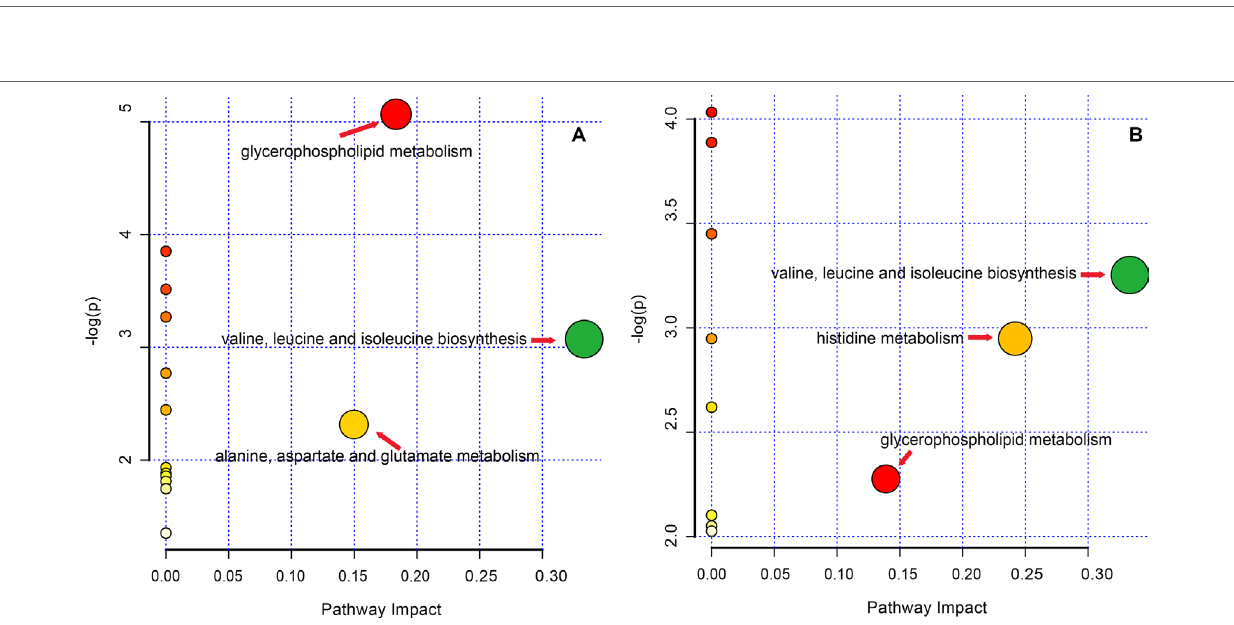
FIGURE 6 | The relative content of common metabolites in the GF, GFC, and NC groups versus the M group. ## P < 0.01, versus the NC group; * P < 0.05, versus the M group; ** p < 0.01, versus the M group. (A) Trans-hexadec-2-enoyl carnitine; (B) 2-hydrohexadecanoylcarnitine; (C) 3-hexenoic acid; (D) lioelaidyl carnitine; (E) L-palmitoylcarnitine; (F) methyl nicotinate; (G) tetradecanoylcarnitine. Plots showed that seven common feature metabolites of the GF and GFC groups were significantly recalled using a multiple t -test. Besides, these seven common metabolites were significantly recalled in the GFC group with a false discovery rate (FDR) below 1%, receptively.